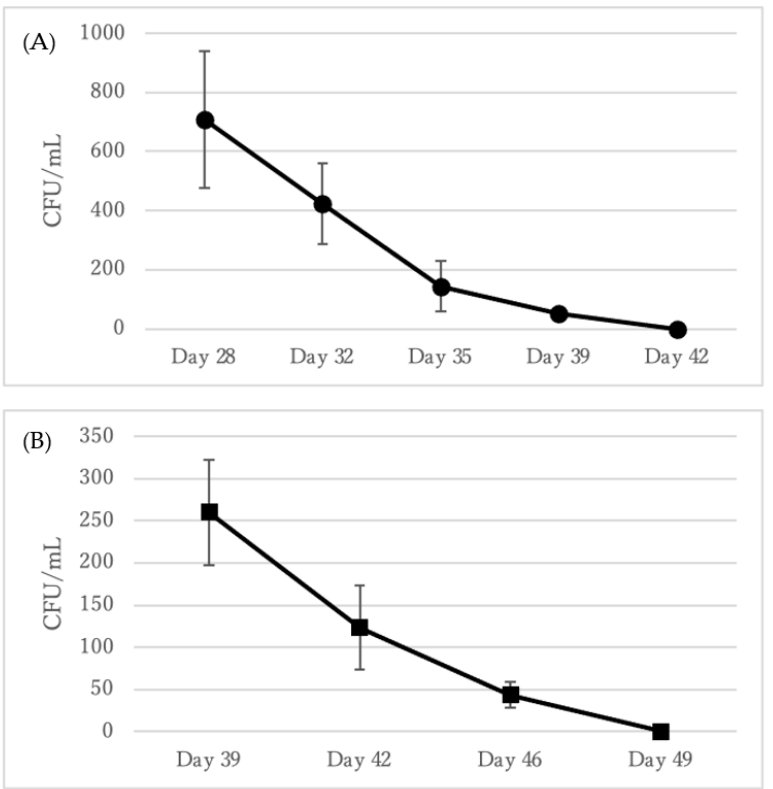
Figure 3. The number of resuscitated C. diphtheriae ATCC700971 ( A ) and ATCC27010 ( B ) cells follow- ing catalase treatment. Error bars represent the mean ± S.D. from three independent experi- ments.